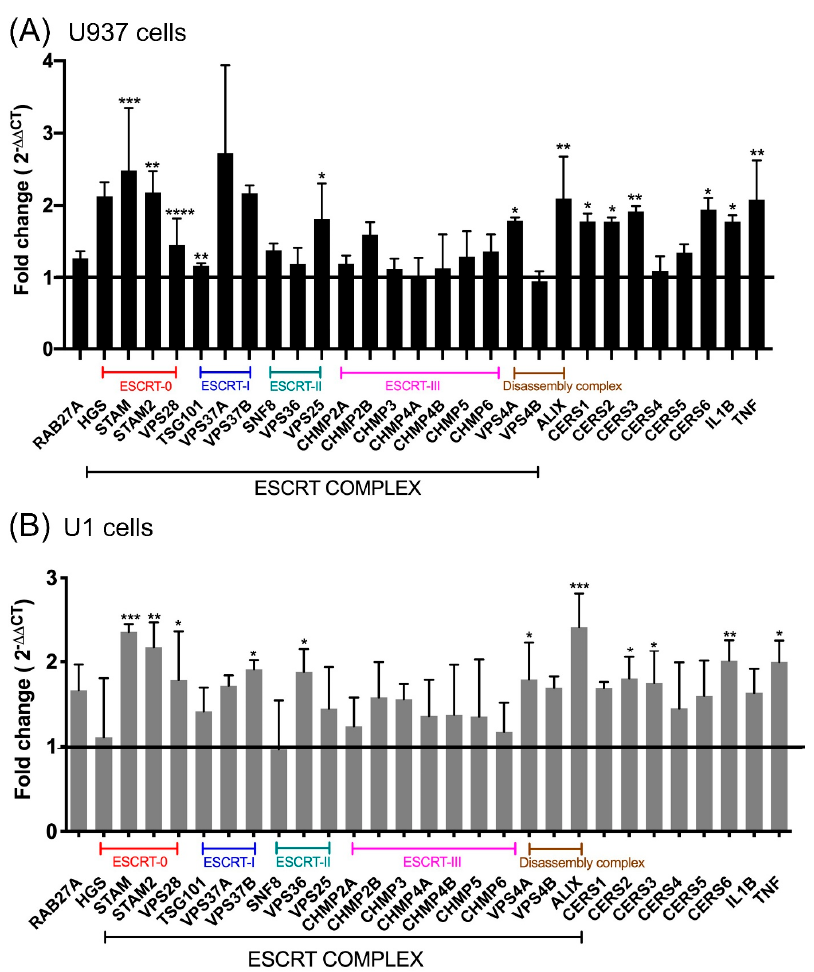
Figure 2. Uninfected control U937 ( A ) and chronically HIV-infected U1 cells ( B ) were treated with 100 µM meth for 24 h. qPCR was performed on the RNA isolated from the cells. Data are presented as a fold change in expression relative to untreated control. Multiple t-tests were performed to calculate statistical significance between groups n = 3 (biological replicates), post hoc analysis was performed using the Fisher’s LSD. * p < 0.05; ** p < 0.01; *** p < 0.001; **** p < 0.0001.